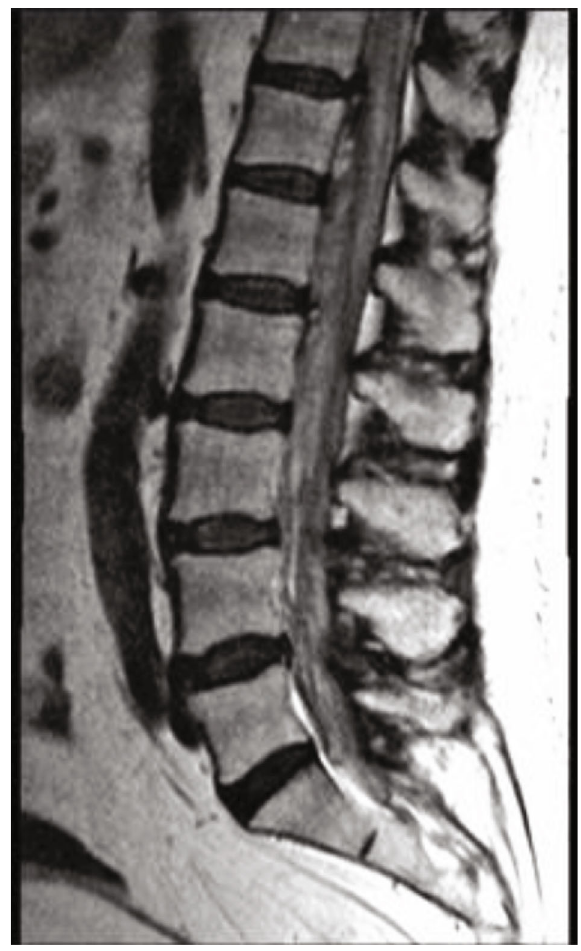
Figure 1: T2-weighted MRI of the lumbar spine demonstrating ventral hypointensity relative to CSF, compressing the conus and cauda